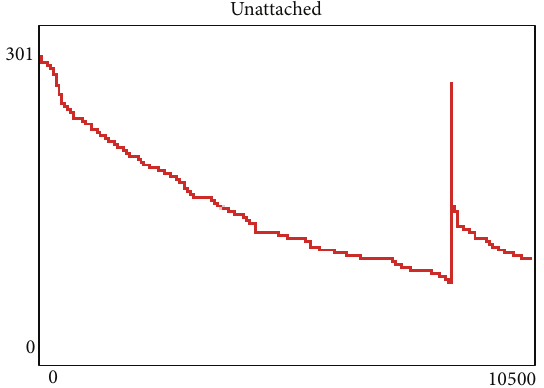
Figure 4: Effect of resilience in the face of losing the leader.